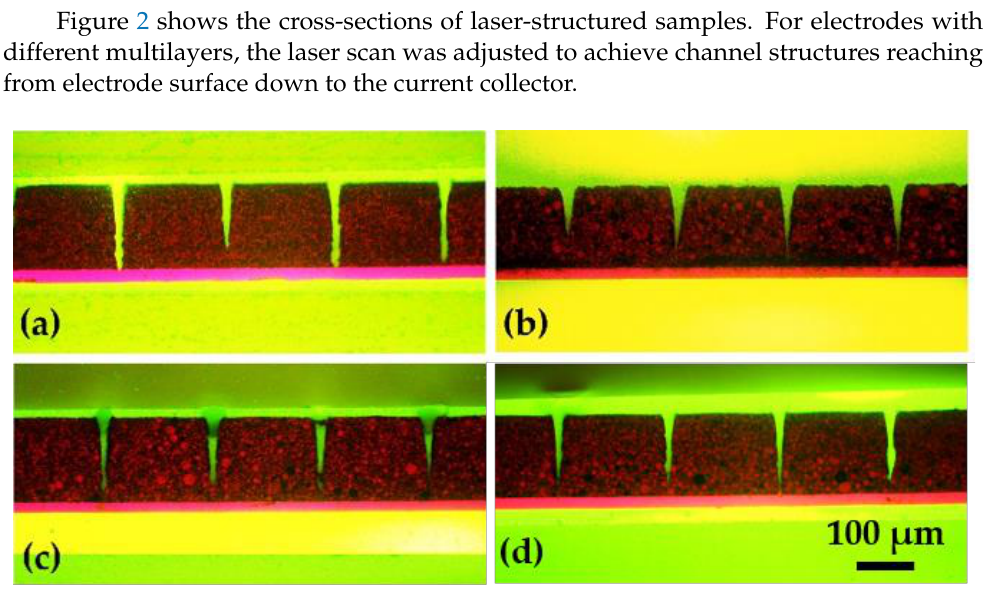
Figure 2. Microscopic images of thick-film electrodes in cross-sectional views. The number of laser scans has been adjusted to enable ablation down to the current collector: ( a ) TA, 14 scans; ( b ) BA, 22 scans; ( c ) BT, 15 scans; ( d ) BTA 1:1, 15 scans.